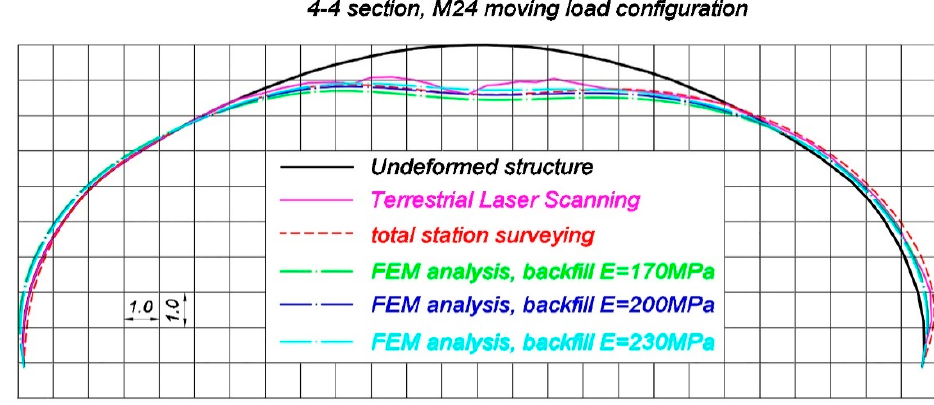
Figure 24. Comparison of the deformed shapes of the bridge in 4-4 section during the moving load M24 configuration, measured using terrestrial laser scanning, total station, and estimated by means of FEM (deformations in (mm) are 1000 times scaled).